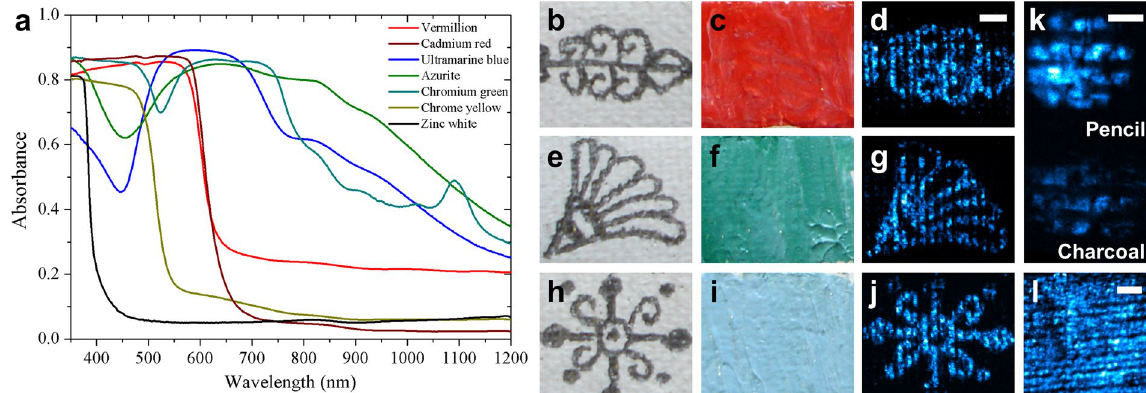
Figure 2. Photoacoustic imaging of various test paint samples. ( a ) Vis-NIR absorption spectra collected in diffuse reflectance mode of test pigments. ( b ) Brightfield view of a pencil sketch on canvas. ( c ) Brightfield view of the previous sample overpainted with a red paint, vermillion. ( d ) Recovered pattern of the initial underlying sketch through photoacoustic imaging. Scalebar: 2 mm. ( e – g and h – j ) Images for chromium green and ultramarine blue paints and corresponding underdrawings respectively. ( k ) A direct photoacoustic signal comparison between pencil and charcoal sketches coated with a zinc white paint layer. Scalebar: 1 mm. ( l